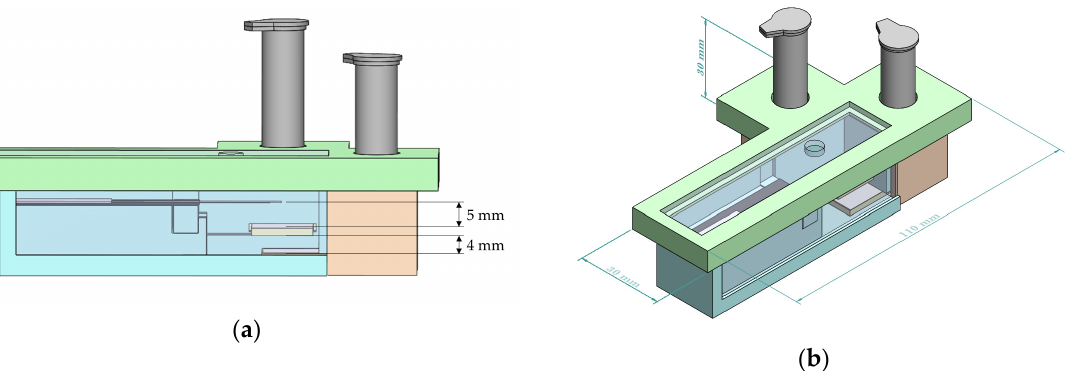
Figure 5. ( a ) A side view of the platform. ( b ) An isotropic view with dimensions of the platform.